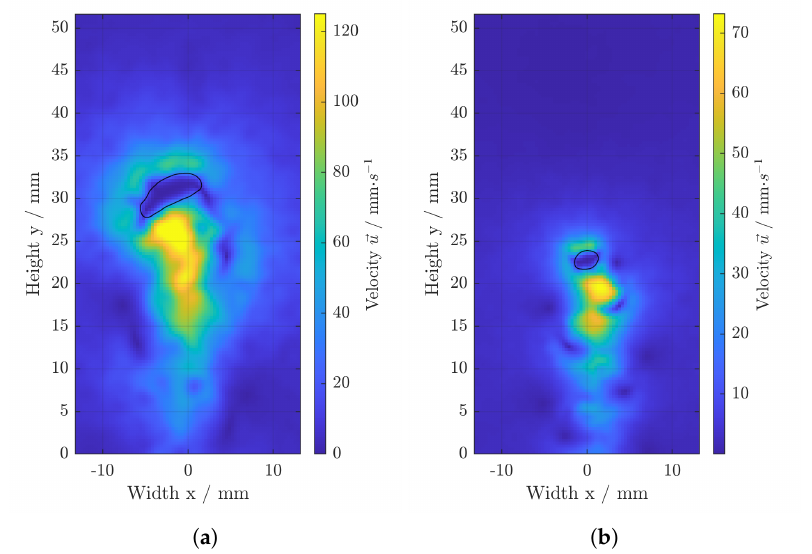
Figure 2. Exemplary fields of the velocity magnitude for ( a ) a wobbling bubble and ( b ) an ellipsoidal bubble. The bubble outlines are denoted in